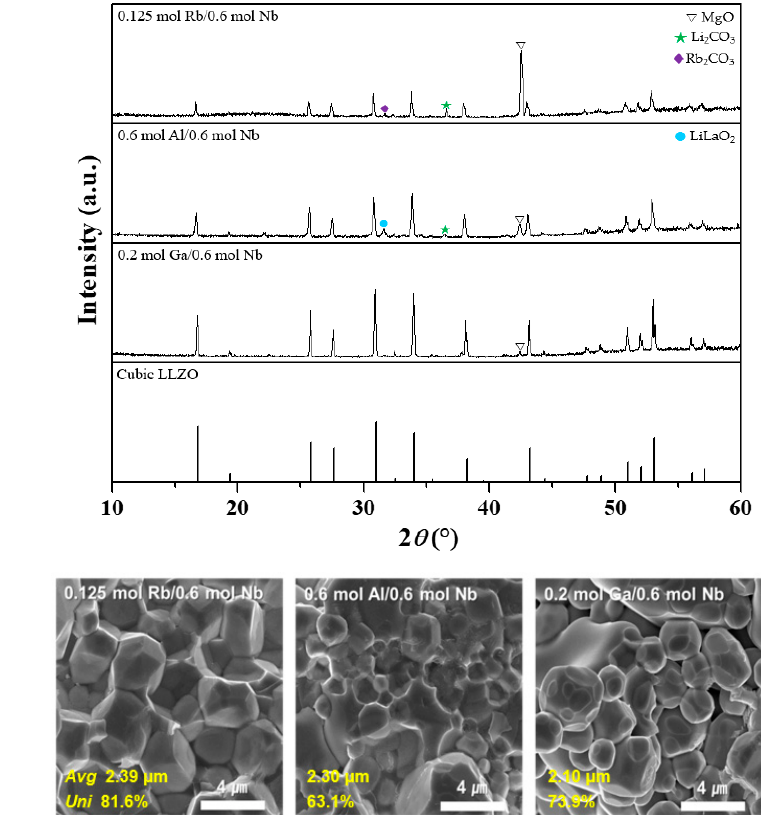
Figure 5. Crystal structure and morphology of co-doped LLZO ceramics (co-doping of 0.125 mol Rb, 0.6 mol Al, or 0.2 mol Ga with 0.6 mol Nb): ( a ) XRD patterns and ( b ) SEM images of the fracture surfaces ( Avg and Uni : the average and the uniformity of grain size,